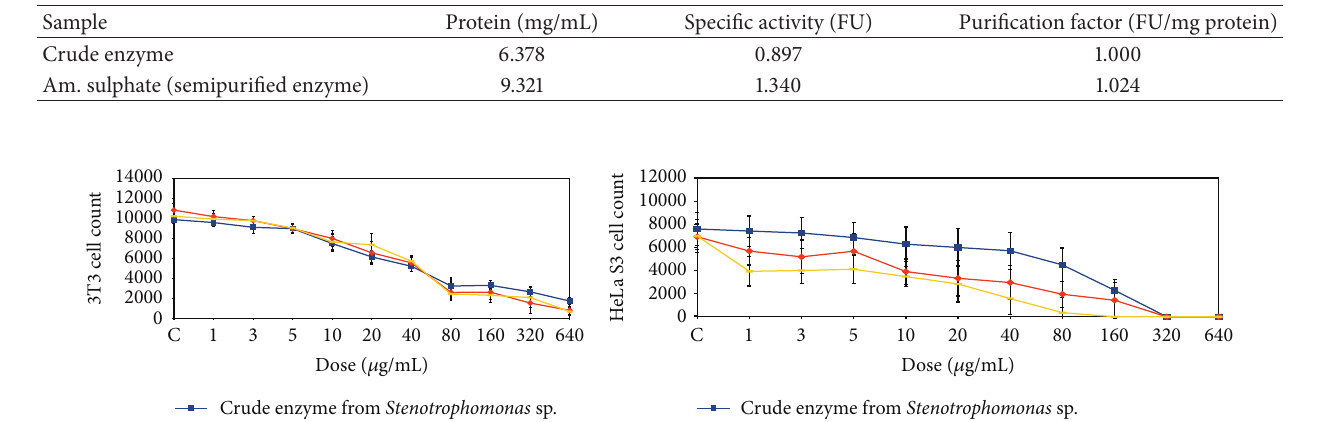
Table 1: Specific activity of fibrinolytic enzyme produced by Stenotrophomonas sp.